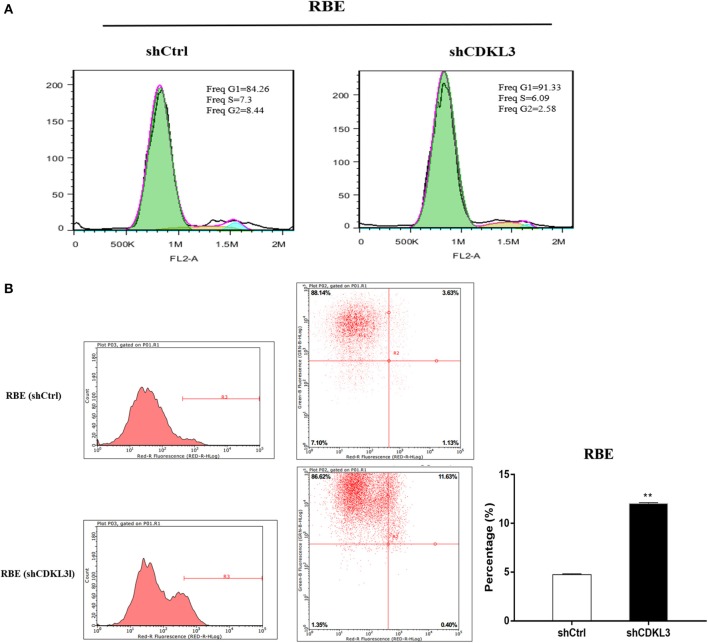
Knockdown of CDKL3 blocks cell cycle progression at G1 phase and induces apoptosis in CCA cells. (A) RBE cells transfected with shCDKL3 showed increased percentage of cell population in G0/G1 phase; (B) Knockdown of CDKL3 in RBE cells led to a significant increase in apoptosis as compared to the cells without CDKL3 knockdown (12.02% vs. 4.73%, P < 0.01). The data represent mean ± SD. *P < 0.05, **P < 0.01, as compared with shCtrl.